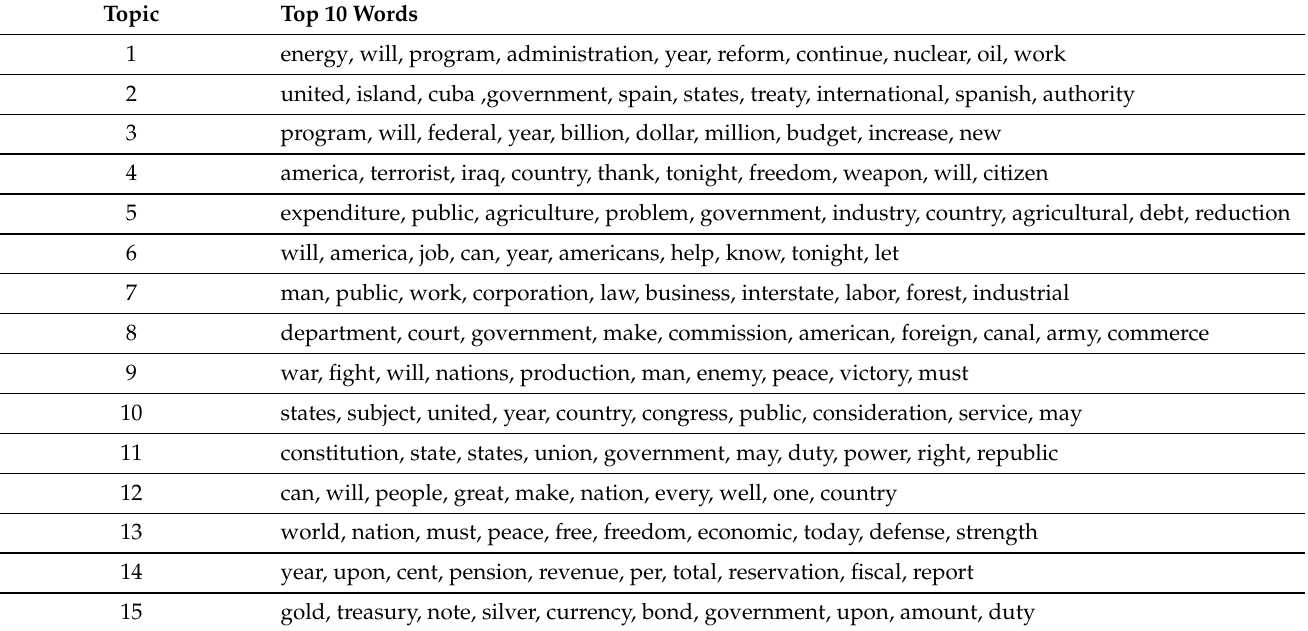
Table 2. Top 10 words from the estimated Topic Scaling with 15 topics.